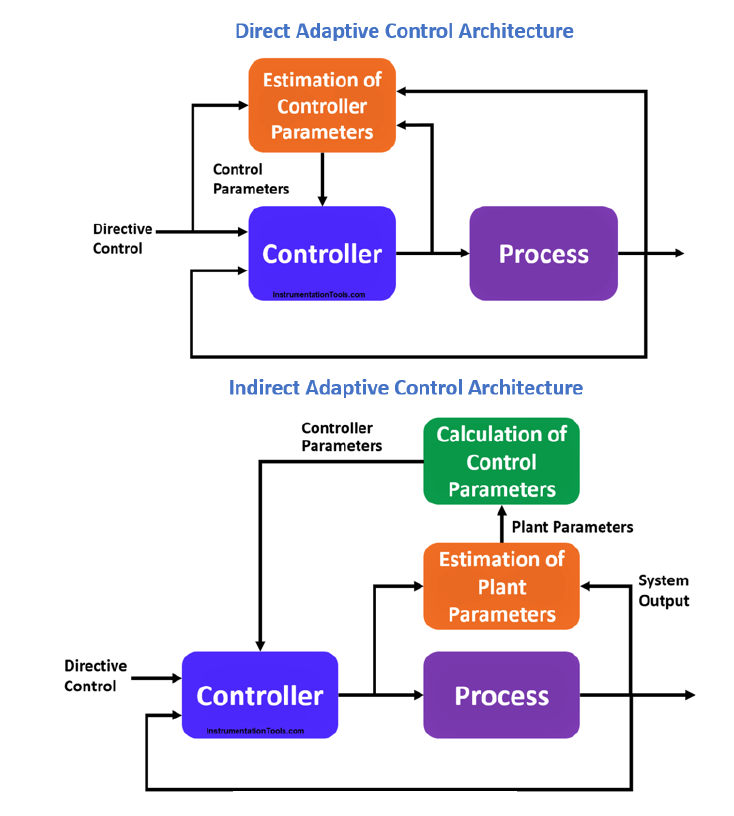
Figure 20. A schematic representation of direct vs. indirect adaptive